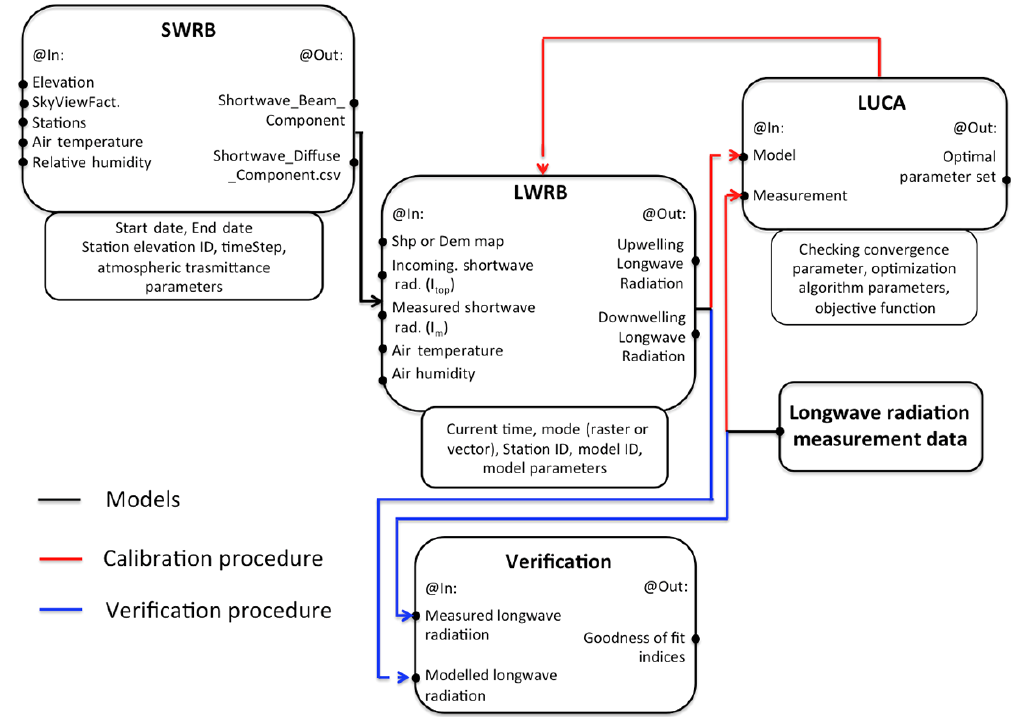
Figure 1. The LWRB component of JGrass-NewAge and the flowchart to model longwave